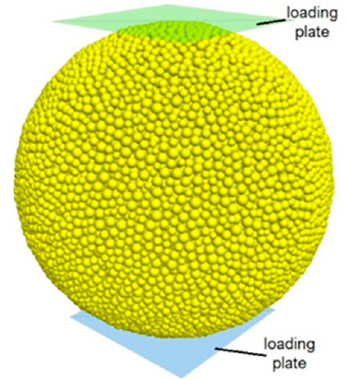
Figur e 12 . Original numerical model Figure 12. Original numerical model.